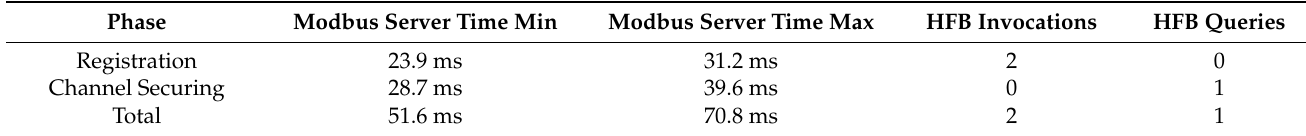
Table 4. Processing time measurements of three-phases of mbapSSI for the